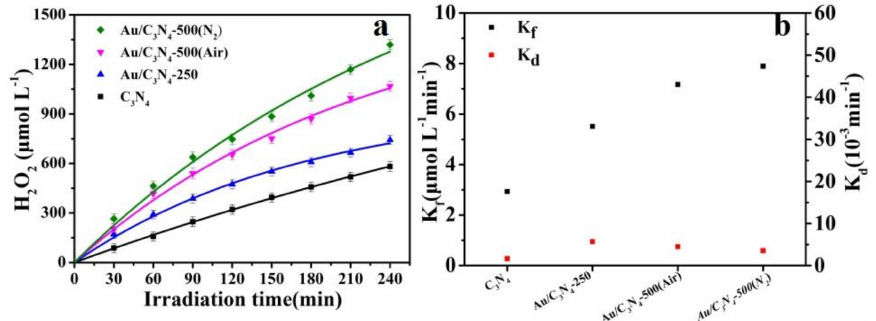
Figure 5. ( a ) The light-driven hydrogen peroxide (H 2 O 2 ) generation in an O 2 -equilibrated aqueous solution over C 3 N 4 , Au/C 3 N 4 -250, Au/C 3 N 4 -500(Air), and Au/C 3 N 4 -500(N 2 ). The experimental